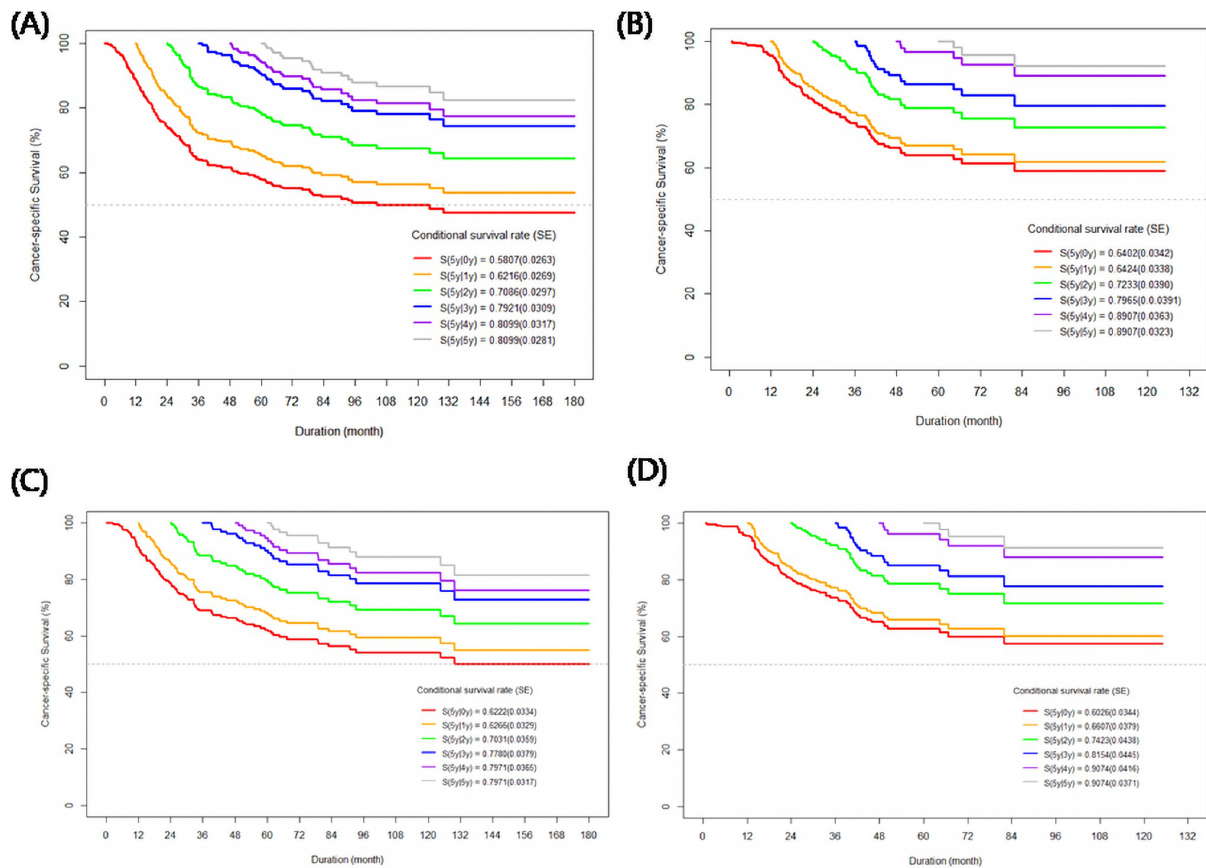
Fig 1. Conditional cancer-specific survival curves according to the surgical approaches in full dataset (A, open vs B, laparoscopic RNU) and matched dataset (C, open vs B, laparoscopic RNU). RNU, radical